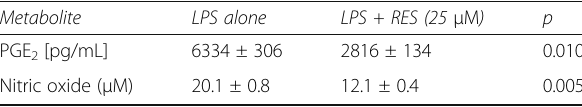
Table 1 Production of PGE 2 and nitric oxide in LPS-stimulated RAW264.7